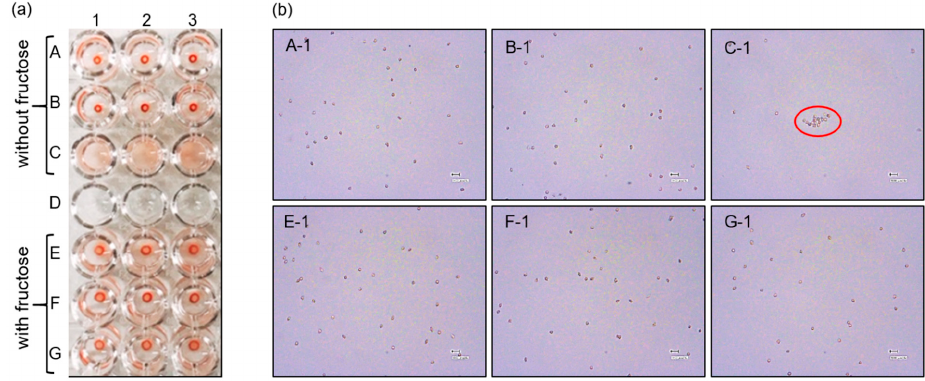
Figure 6. Fructose’s effect on RBC agglutination. ( a ) Visual appearance of the microplate. Each condition contained blood (1/800) and was repeated thrice in columns 1–3. The wells in rows A (without insulin or PBA-Ins), B (with insulin), and C (with PBA-Ins) lacked fructose. The wells in row E (without insulin or PBA-Ins), F (with insulin), and G (with PBA-Ins) contained 307 mM fructose. ( b ) Microphotographs of the contents of wells (column 1) for each condition. Agglutination of RBCs is marked with a red circle in the panel for C-1.